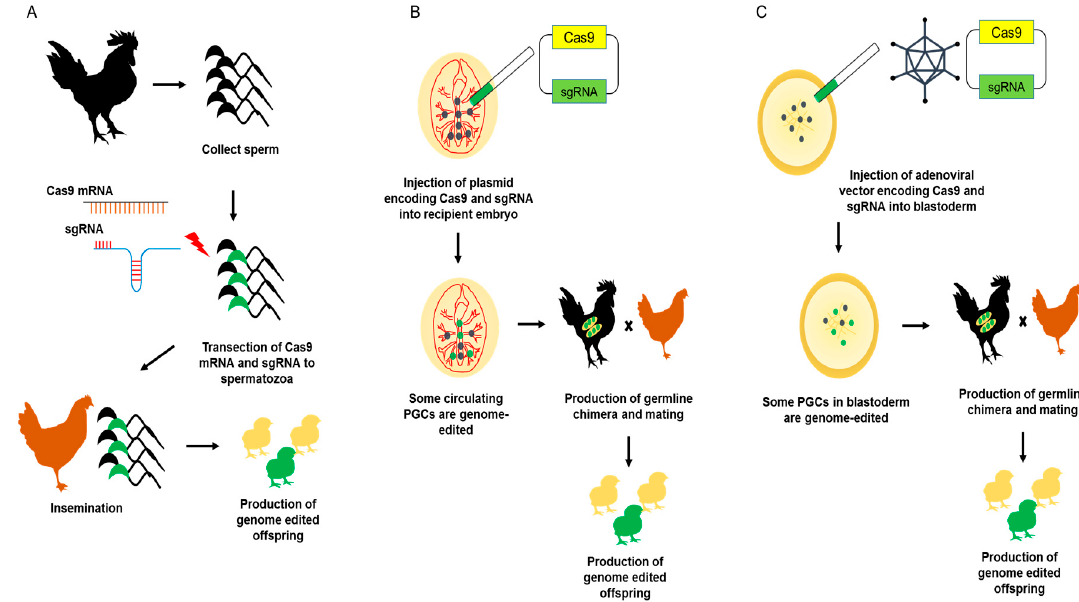
Figure 2. Schematic illustration of cultured-PGCs free genome-editing method in poultry. ( A ) Schematic illustration of STAGE. The spermatozoa collected from roosters are transfected with Cas9 mRNA and single guide RNA (sgRNA). The transfected spermatozoa were inseminated to adult hen and genome-edited offspring finally produced. ( B ) Schematic illustration of in vivo germ cell transfection. The plasmid encoding Cas9 and sgRNA is injected in recipient embryo bloodstream. Then, some circulating PGCs are transfected and genome-edited. After that, the germline chimera will be produced and genome-edited offspring finally produced after mating. ( C ) Schematic illustration of adenoviral vector injection. The adenoviruses containing vector encoding Cas9 and sgRNA are injected in the blastoderm and some PGCs in the blastoderm are infected with adenovirus and genome-edited. After that, the germline chimera will be produced and genome-edited offspring finally produced after mating.